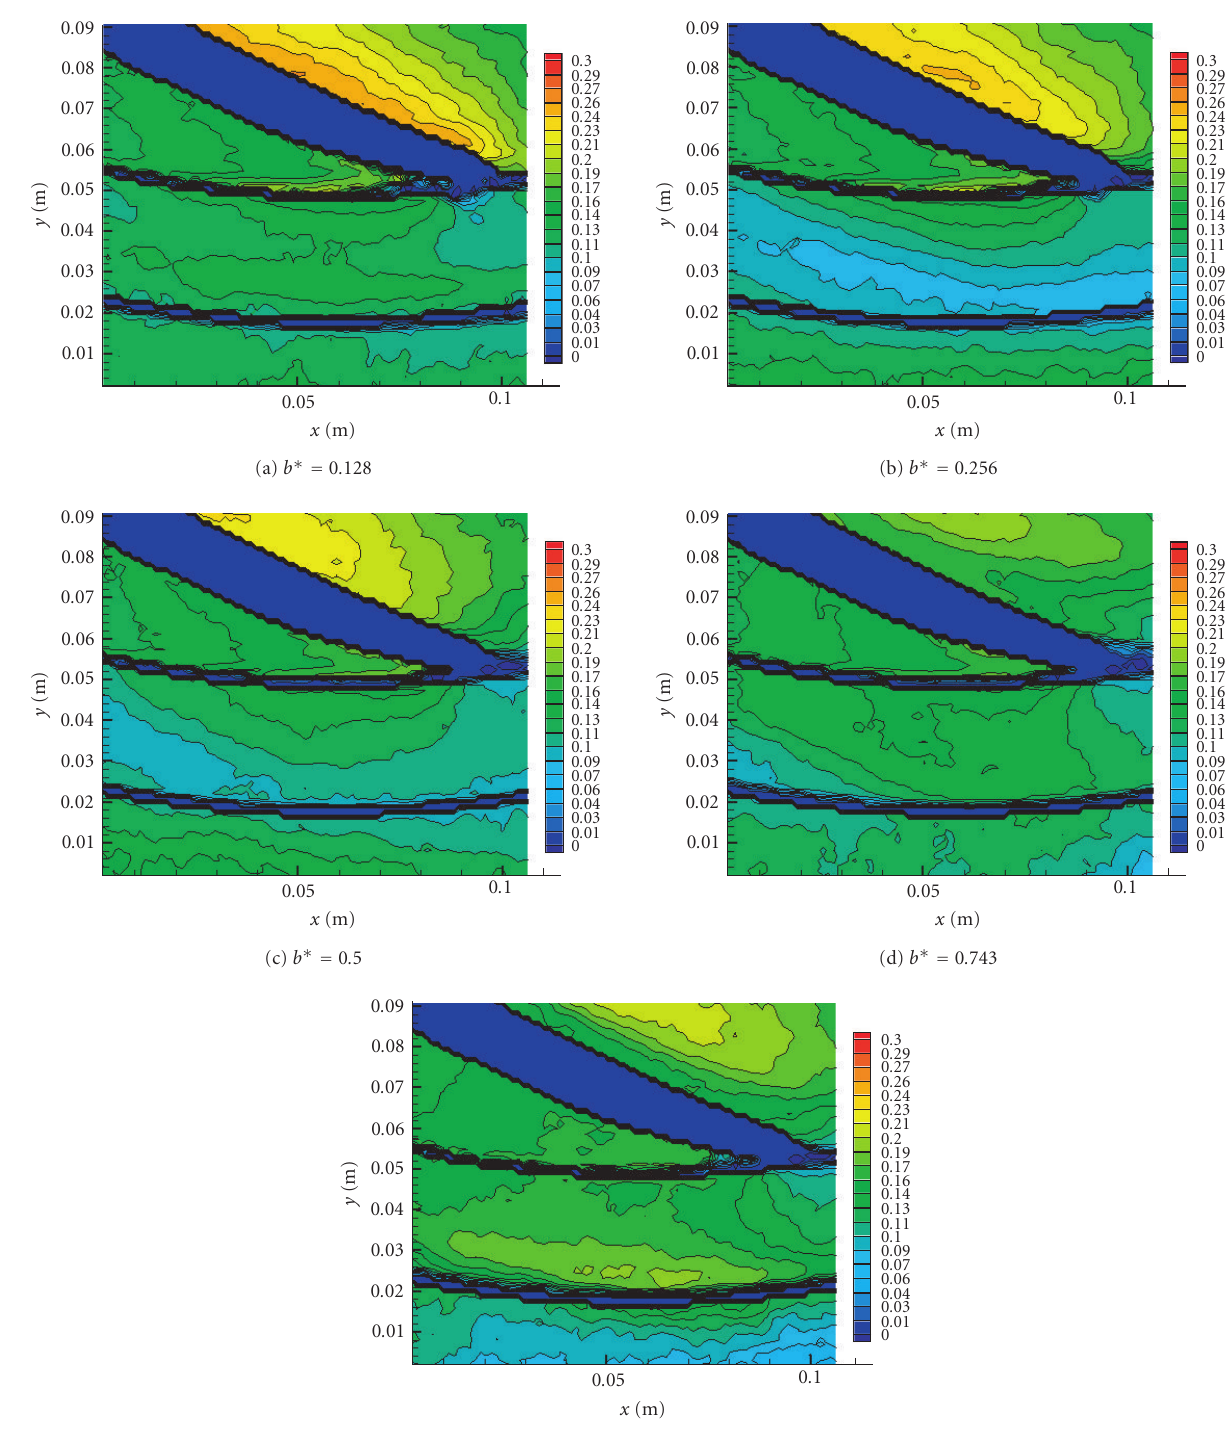
Figure 7: Radial